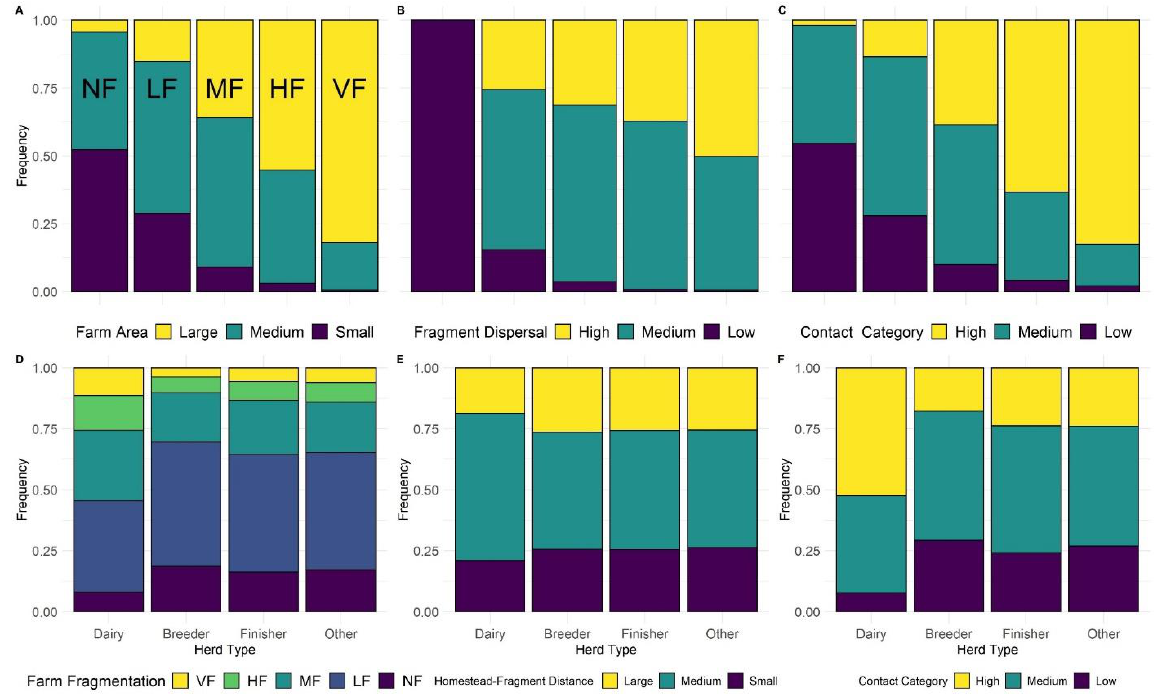
Figure 3. The relationship between ( A ) farmland fragmentation and farm area, ( B ) farmland fragmentation and dispersal, and ( C ) farmland fragmentation and exposure to other farms (via shared perimeter). Farmland fragmentation levels on the x -axis are Not Fragmented (NF); Little Fragmentation (LF), Medium Fragmentation (MF); High Fragmentation (HF); Very High Fragmentation (VF). The relationship between ( D ) farmland fragmentation and production type, ( E ) fragment dispersal and production type, and ( F ) exposure to other farms (via shared perimeter) and production type.